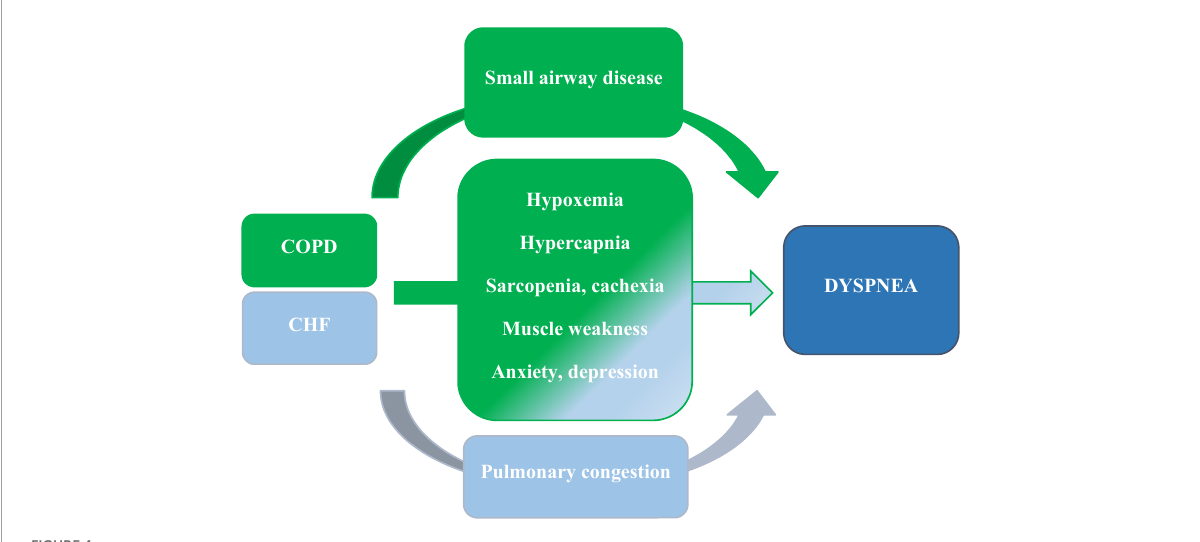
FIGURE4 The major causes of dyspnea in people living with COPD and CHF coexistence; based on (1–3,